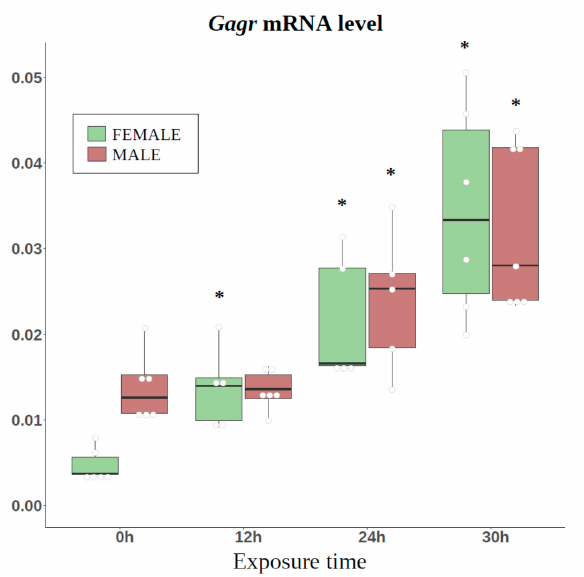
Figure 3. Activation of Gagr expression of D. melanogaster females and males in response to di ff erent times of exposure to 0.1 M ammonium persulfate. *—significant di ff erences relative to the basal level (Mann-Whitney test, p -value < 0.01, N = 5–7). The data are presented as scatterplots and boxplots (median, interquartile range, 5 to 95